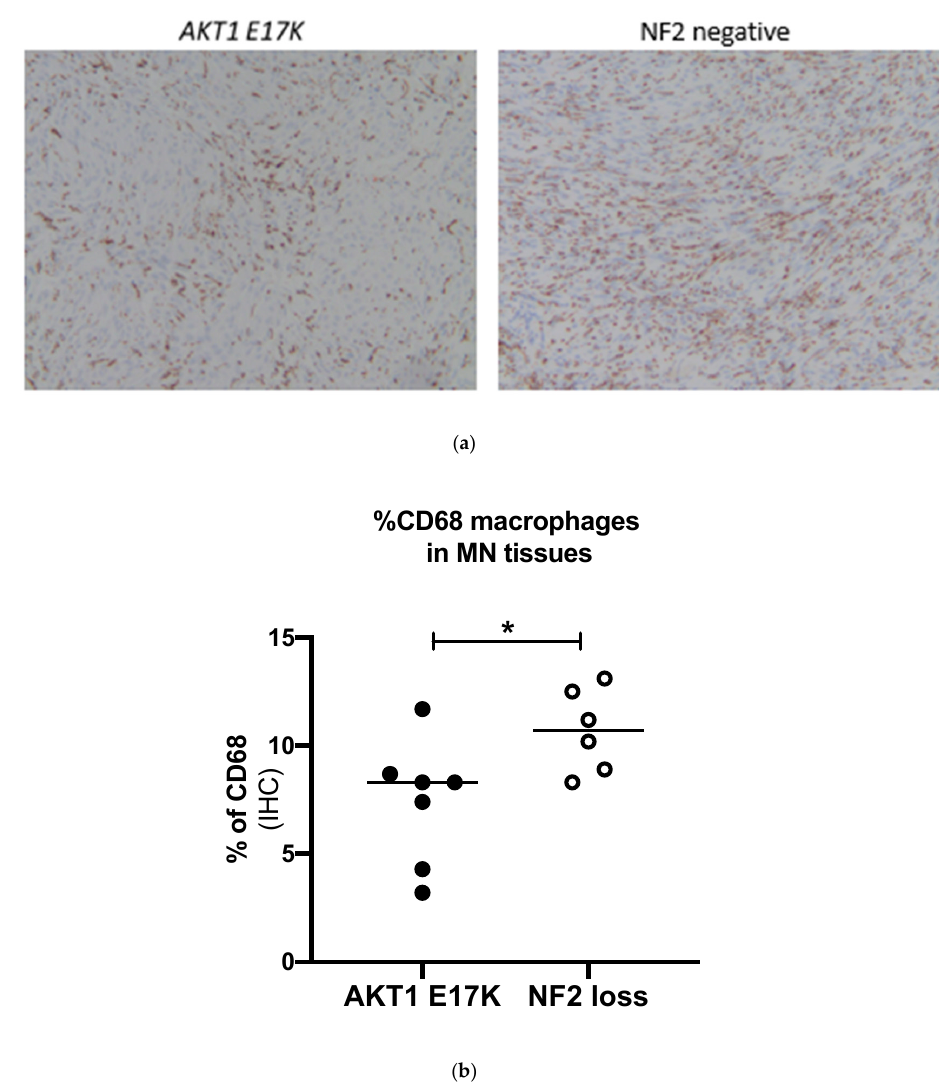
Figure 3. ( a ) Representative immunohistochemistry images for CD68-stained macrophages in AKT1 E17K- and NF2-negative meningiomas, × 100 magnification ( b ) % of CD68 + cells in AKT1 E17K mutants ( n = 7) compared to WHO grade I NF2-negative ( n = 6) meningiomas by IHC; line represents the median, * p <